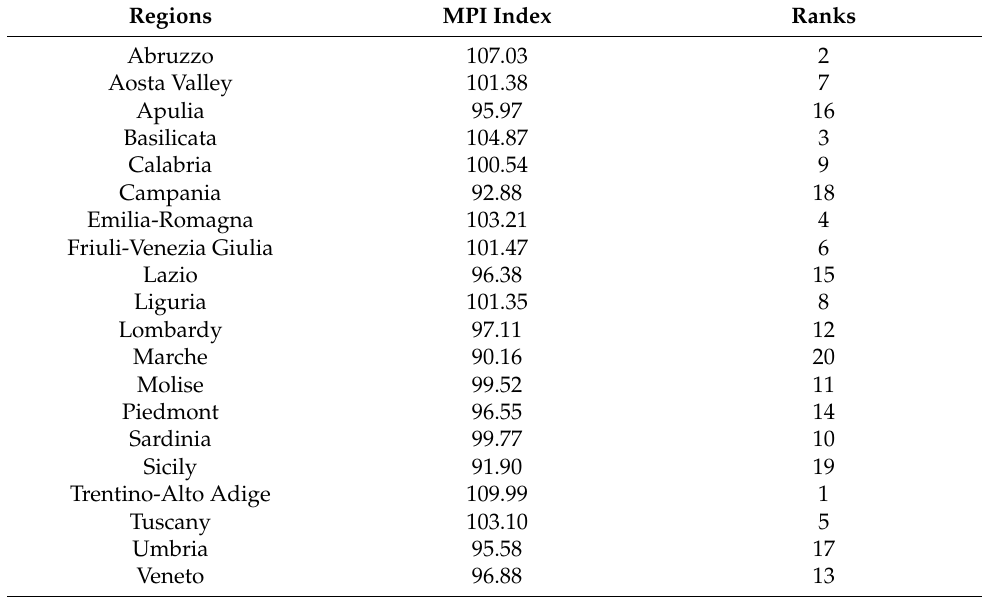
Table 2. MPI Political Participation Index.